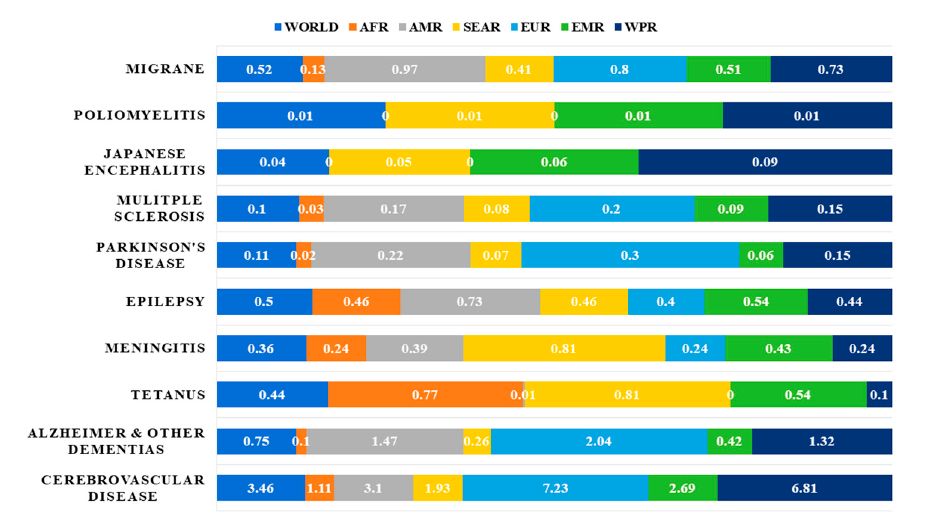
Figure 1. Neurological disorders as percentage of total DALYS by regions as defined by WHO in 2005 [3]. Abbreviations: DALYs: disability-adjusted life years; AFR: Africa Region; AMR: America Region; SEAR: South-East Asia Region; EUR: Europe Region; EMR: Eastern Mediterranean Region; WPR: Western Pacific Region.